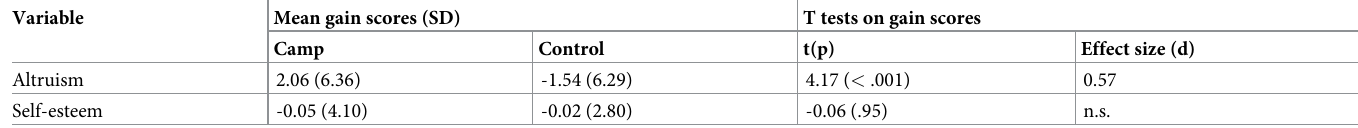
Table 2. Mean gain scores (and standard deviations) of dependent variables, the significance of statistical tests, and the effect